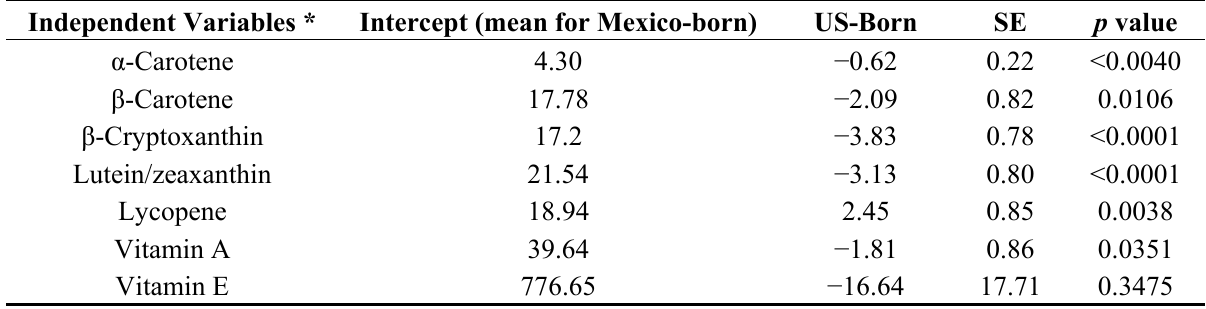
Table 2. Crude Associations of Country of Birth with Serum Concentrations. Independent Variables